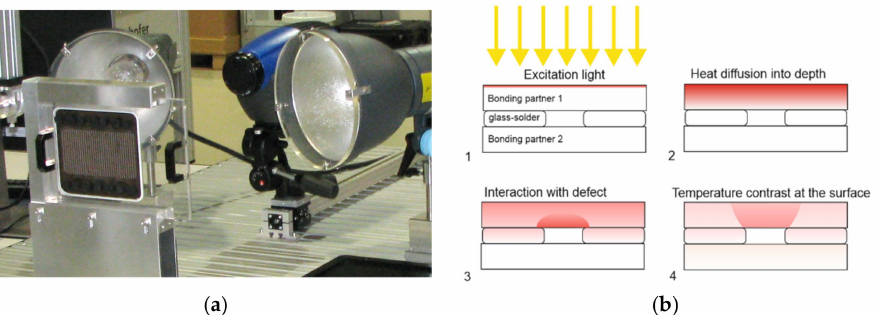
Figure 8. ( a ) Photo of the flash thermography setup with a single cell sample; ( b ) principle of defect